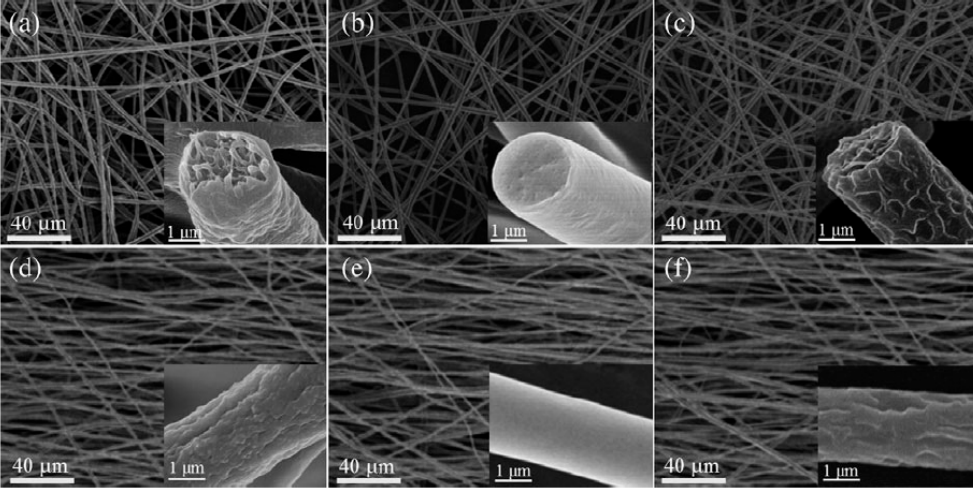
Figure 7. Representative pictures of samples fabricated by electrospinning of PVDF solutions with different morphologies. ( a – c ) Randomly oriented fibers, ( a ) wrinkled, ( b ) smooth, and ( c ) porous. ( d – f ) Aligned fibers, ( d ) wrinkled, ( e ) smooth, and ( f ) porous. Reprinted with permission from [78].